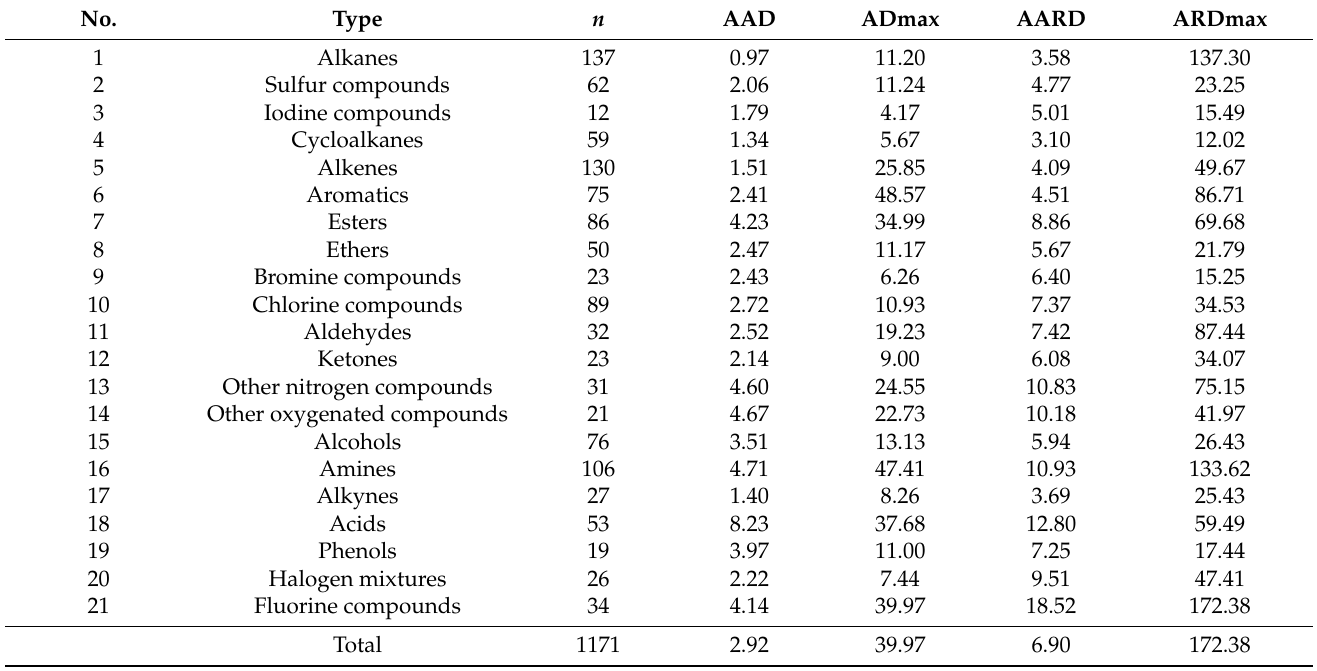
Table 4. Classification and summary of prediction results by Joback method.